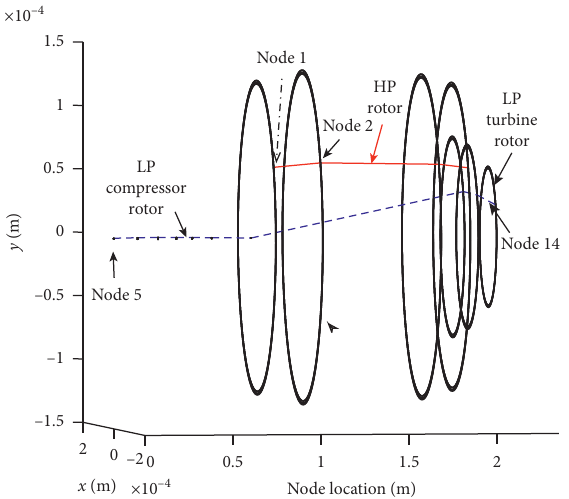
Figure 9: Orbits and modal shapes: ω